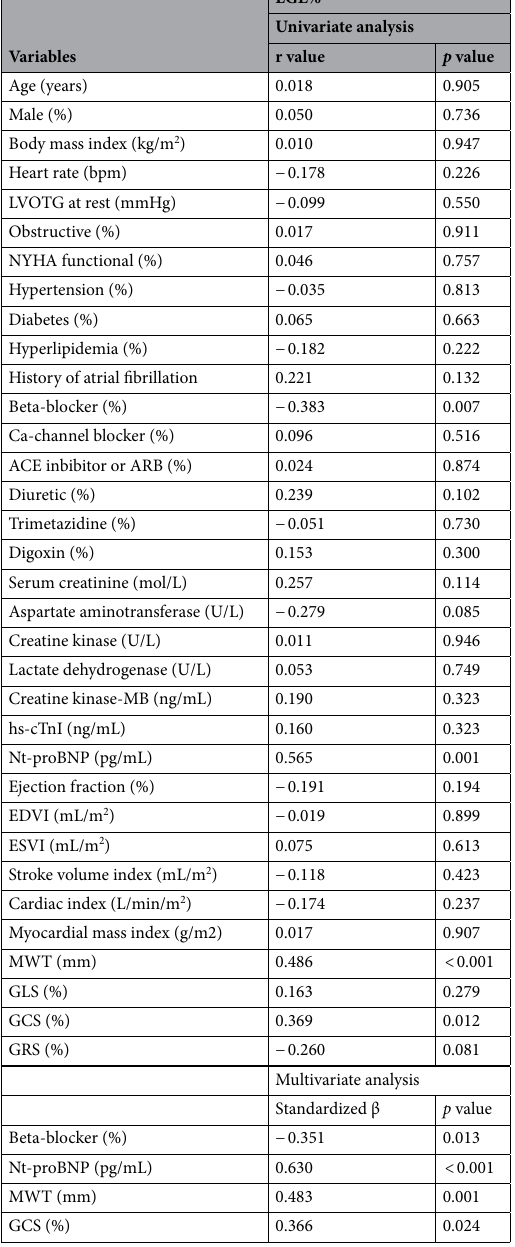
Table 3. Univariate and multivariate regression analysis for LGE (LGE%) and the clinical and CMR indicators in HCM patients. LGE, late gadolinium enhancement; LVOTG, peak left ventricular outflow tract